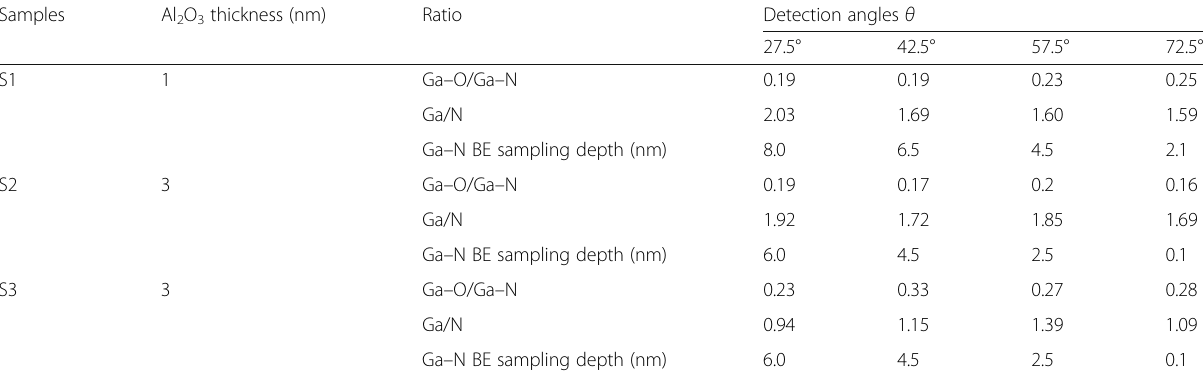
Table 2 Summary of the peak intensity ratio of Ga – O to Ga – N, Ga to N, and the corresponding XPS sampling depth at different detection angles θ Samples